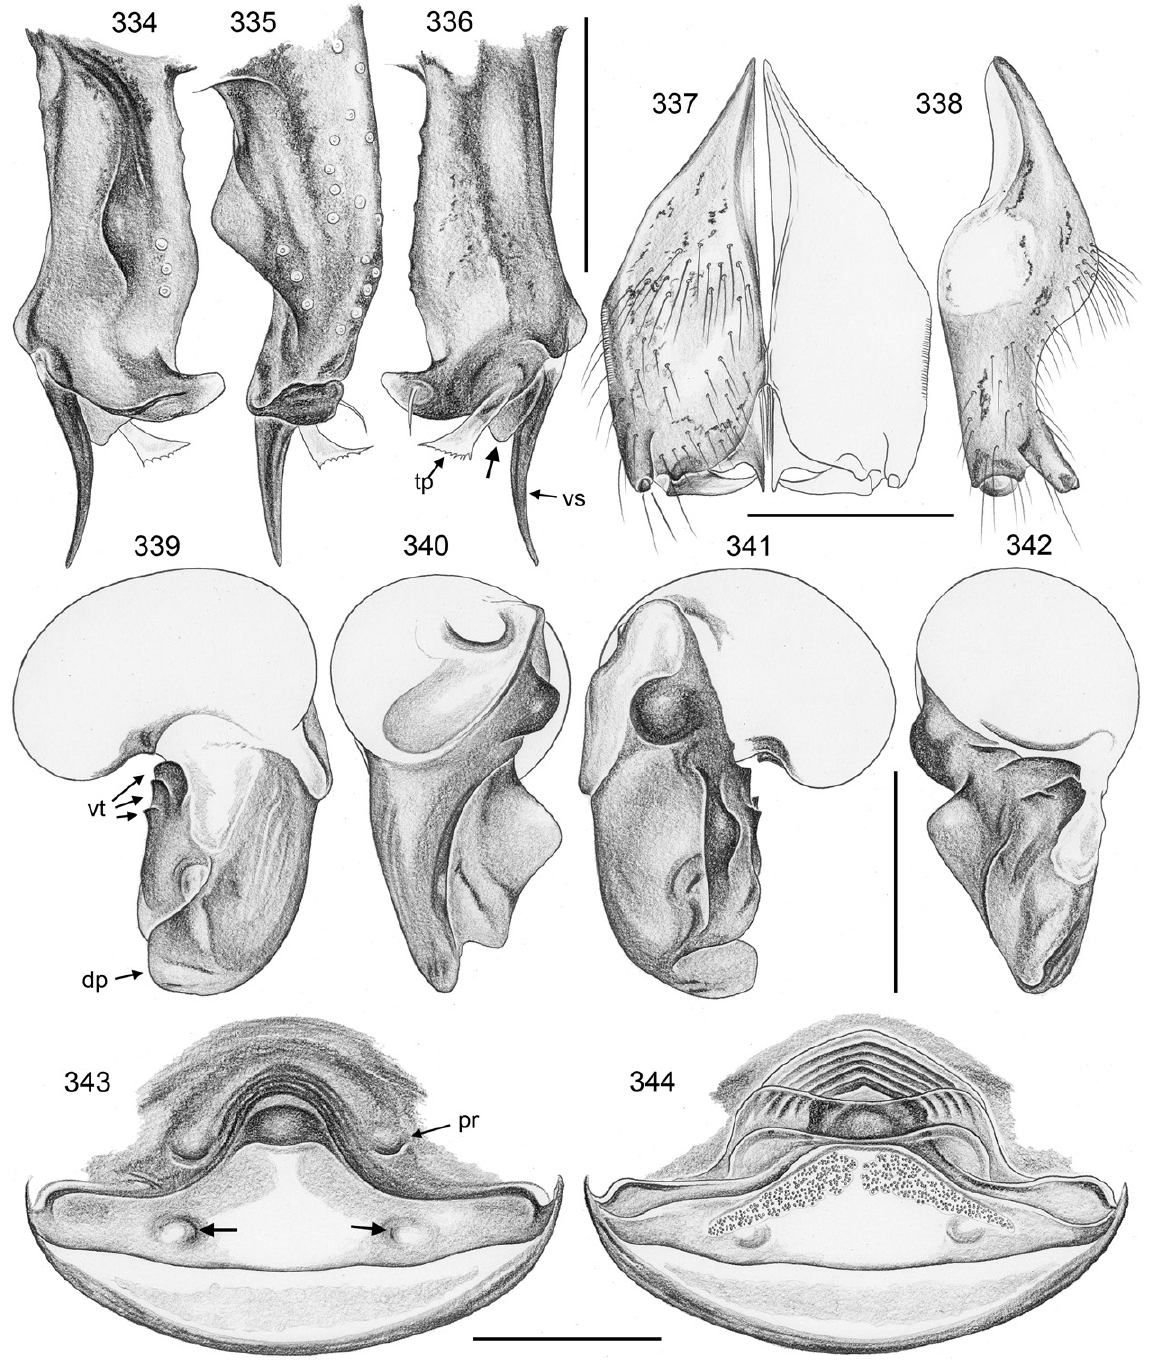
Figs 334–344. Maghreba djabalija gen. et sp. nov.; male and female from Morocco, NE of Tizi n’Test (ZFMK Ar 22389, Ar 22390). 334–336 . Left procursus, prolateral, dorsal, and retrolateral views; arrow: dark process between ventral sclerite and transparent process. 337–338 . Male chelicerae, frontal and lateral views. 339–342 . Left genital bulb, prolateral, dorsal, retrolateral, and ventral views. 343– 344 . Cleared female genitalia, ventral and dorsal views; arrows: pockets (pits). Abbreviations: dp = dorsal process; pr = epigynal process; tp = transparent process; vs = ventral sclerite; vt = ventral teeth. Scale bars = 0.3